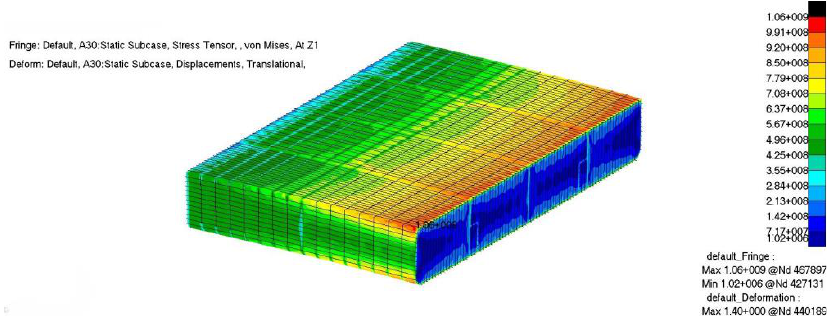
Figure 29. Stress cloud diagram of decks 4 and 5 at the time of the accident.